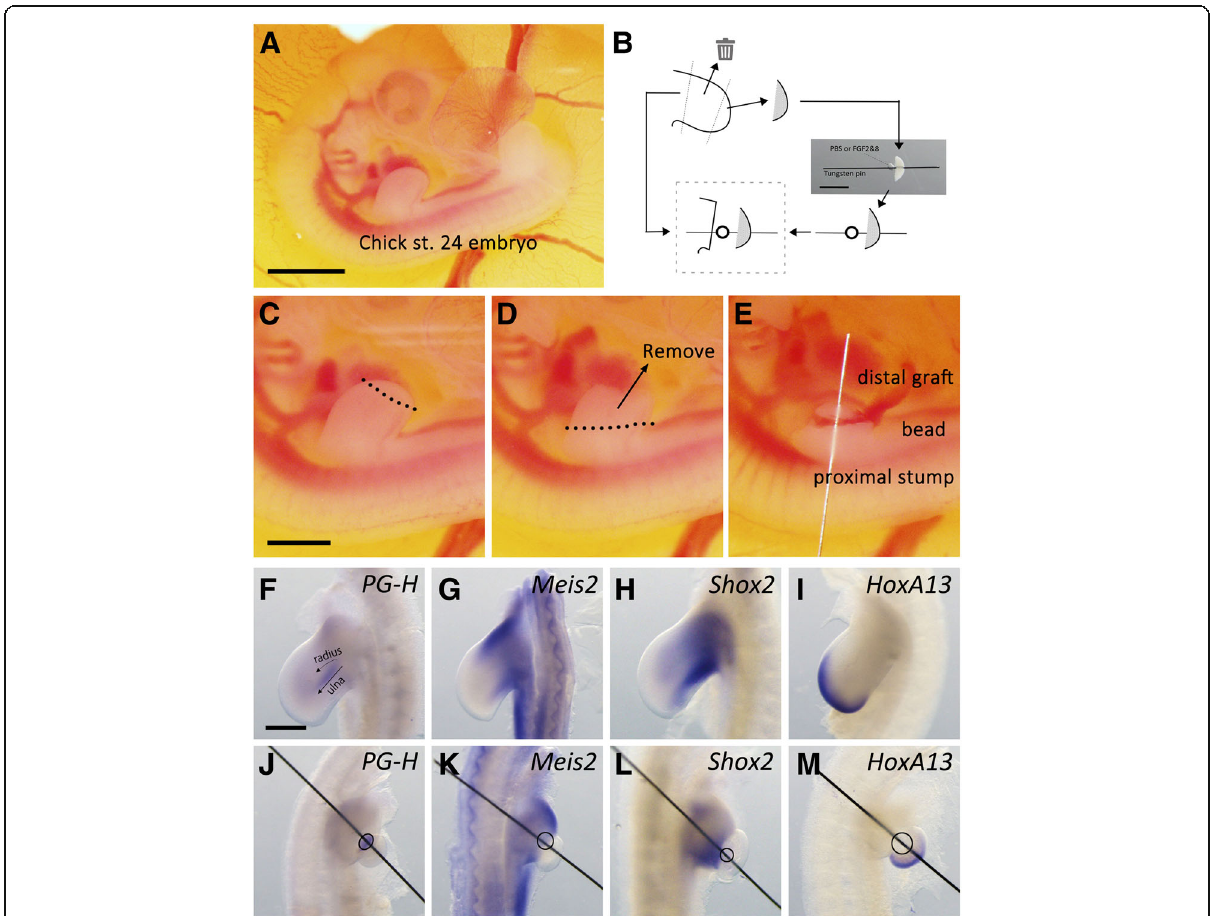
Fig. 1 Summary of the experimental procedures and gene expression pattern. a Chicken embryo at stage 24, which was used for the surgery in the present study. b – e Summary of surgical procedures. b The schematic diagram of the surgical procedure. The distal one-quarter was isolated and stabbed with a gelatin bead. c The distal one-quarter of the limb bud was dissected out and the isolated part was used for the graft. d The next two quarters, the intermediate part, was removed. e The remaining one-quarter of the stump was stuck with the distal graft and the bead. f – m Gene expression pattern in non-amputated limb buds ( f – i ) and operated limb buds ( j – m ). Pg-h ( Aggrecan ) expression ( f , j ), Meis2 expression ( g , k ), Shox2 expression ( h , l ), and HoxA13 expression ( i , m ). The circles indicate the position of the grafted bead (J – M). The scale bars in a , b , c , and F are 2, 1, 1, and 0.5 mm,